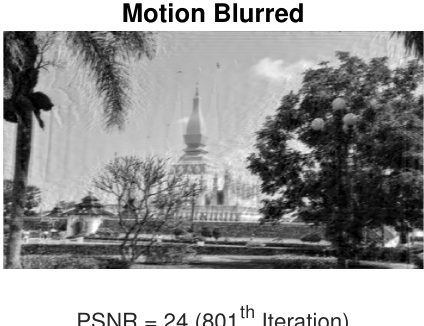
Figure 37. The reconstructed grey image of all cases using the proposed method (2) with PSNR = 24.